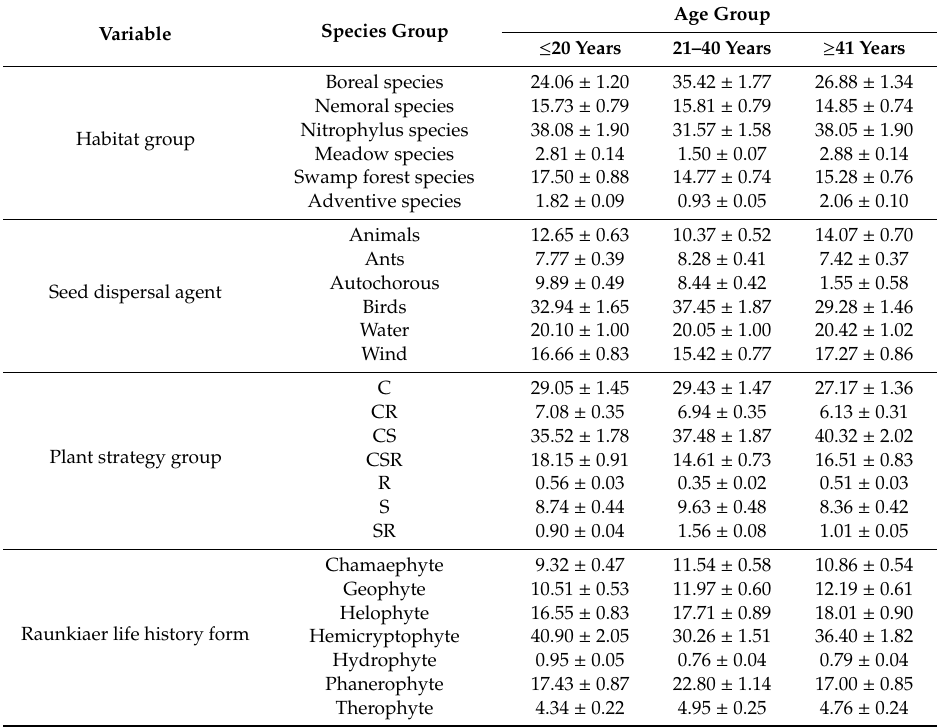
Table A2. Distribution of species by plant ecological features in young ( ≤ 20 years), medium-old (21–40 years) and old ( ≥ 41 years) edges. Average proportion of species is given in percentage, ± standard error is